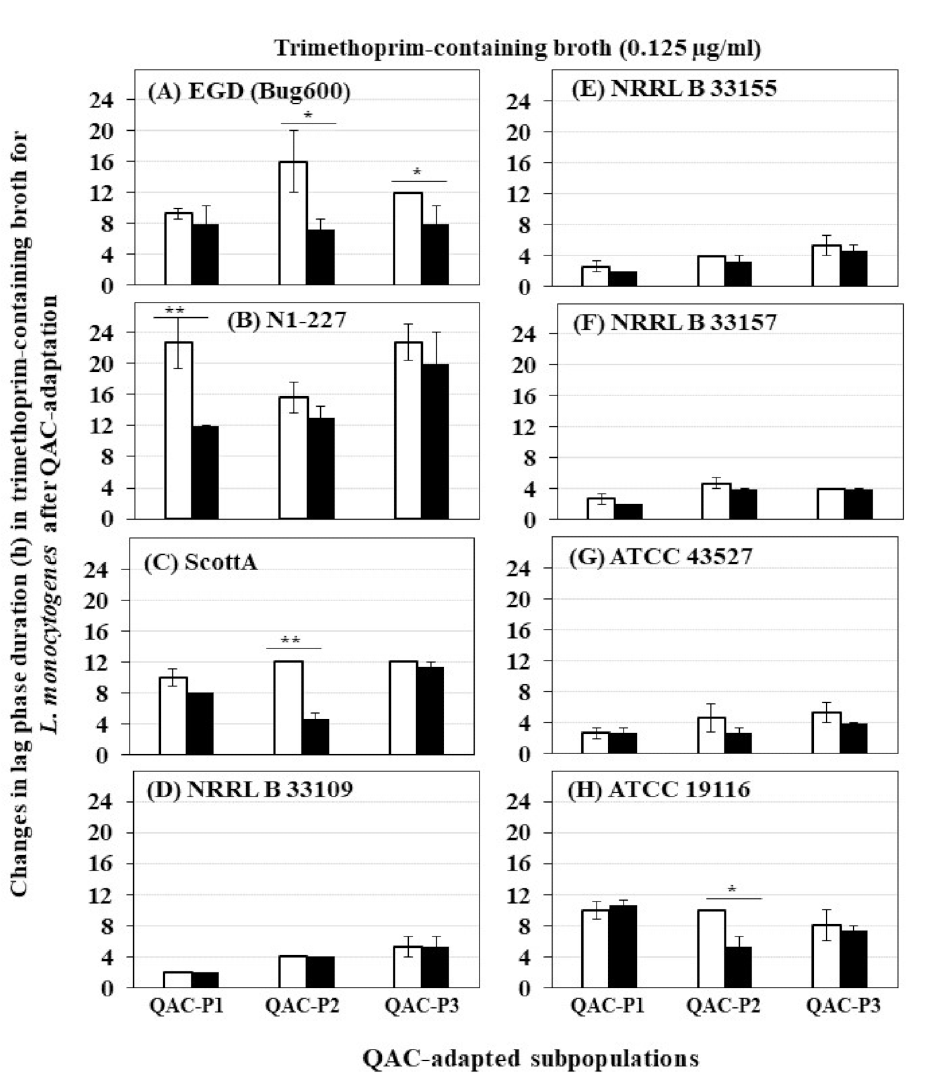
Figure 2. Changes in lag phase duration (h) for three QAC-adapted subpopulations (closed bar) in trimethoprim-containing broth (0.125 µ g/mL) compared to non-adapted controls (NAc) (open bars) of eight L. monocytogenes strains at 37 ◦ C: ( A ) EGD (Bug600), ( B ) N1-227, ( C ) ScottA, ( D ) NRRL B 33109, ( E ) NRRL B 33155, ( F ) NRRL B 33157, ( G ) ATCC 43527, ( H ) ATCC 19116. Error bars indicate standard errors of means. Statistically significant P values are indicated by asterisks (*, p <